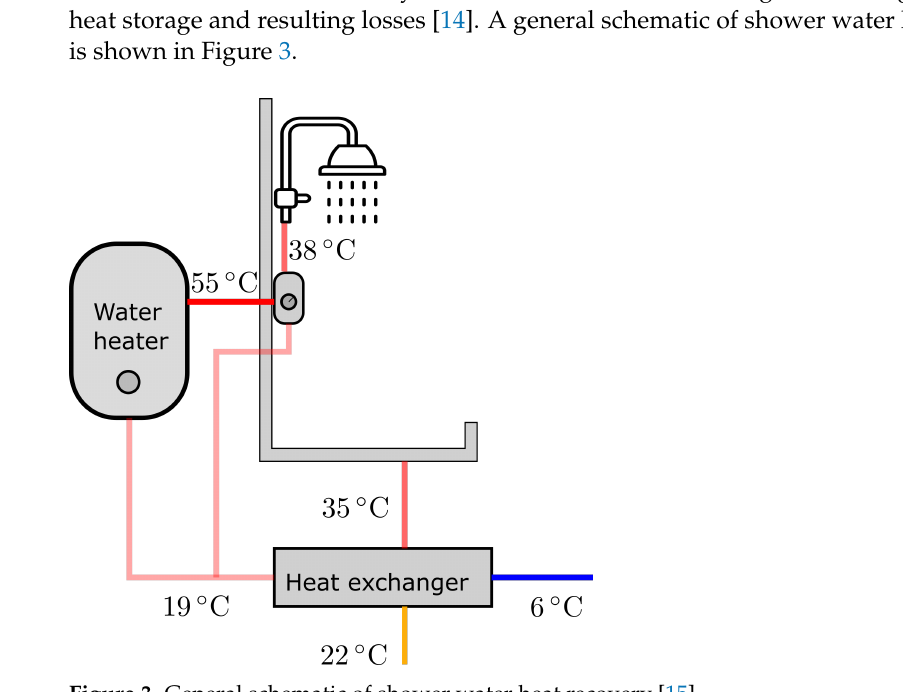
Figure 3. General schematic of shower water heat recovery